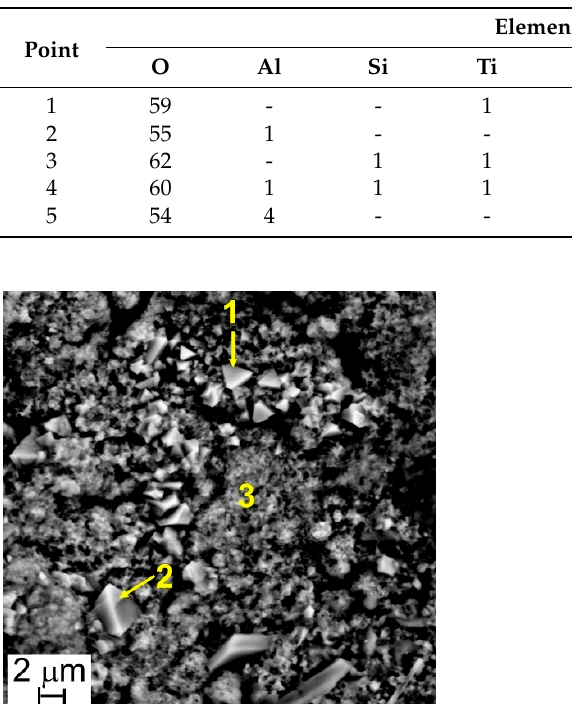
Table 4. Results of EDS analyses (at.%) performed at points of Figure 7.